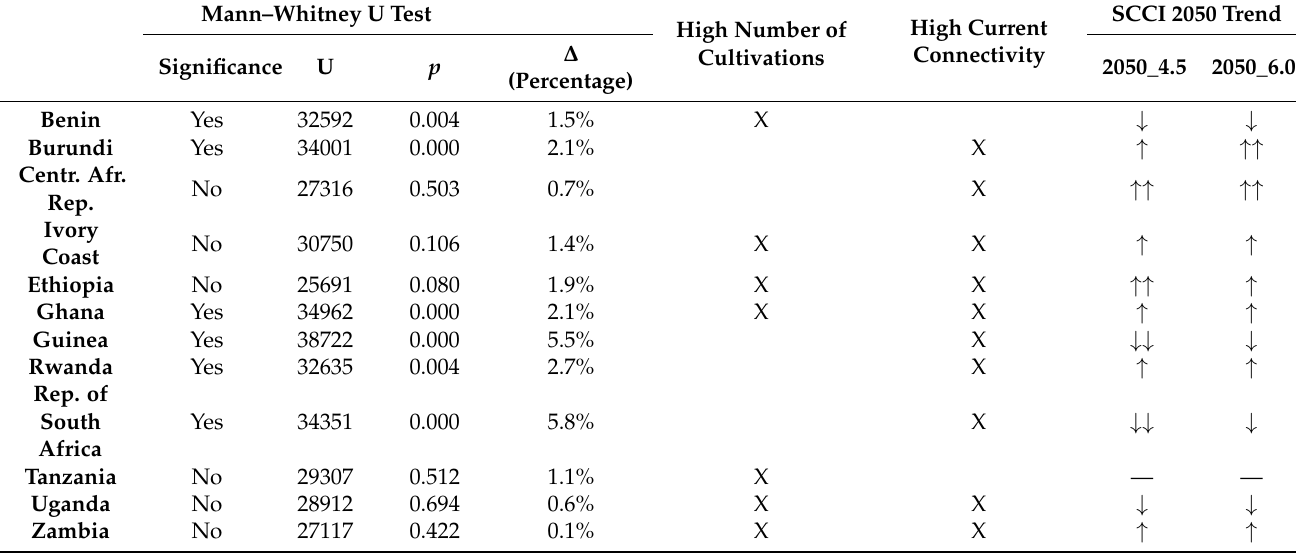
Table 1. Pairs of countries of interest tested for differences between the two 2050 scenarios considered, the RCP4.5 and the RCP6.0, with the corresponding variation between them ( ∆ , reported as percent difference), their features and future trend of increase, stability or decrease in predicted connectivity (double arrows represent a stronger trend). Mann–Whitney U